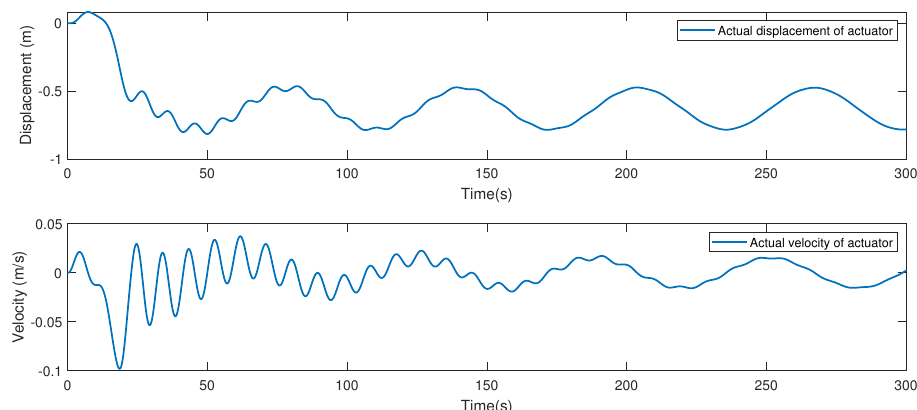
Figure 14. The position and velocity trajectory of the SEA actuator.